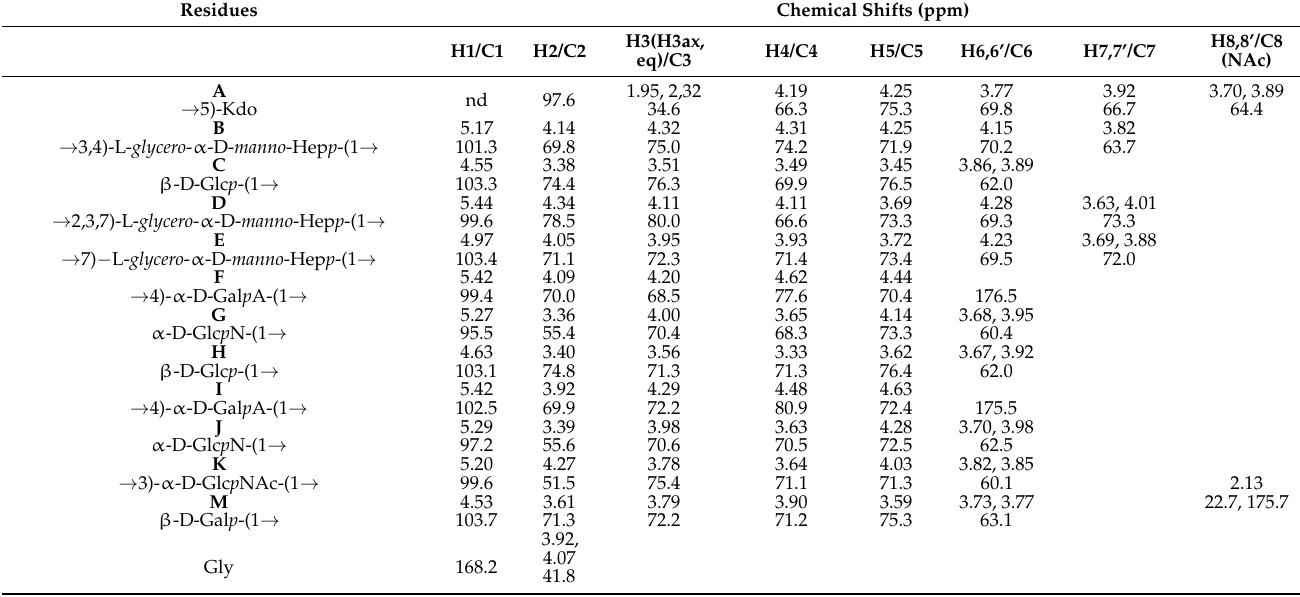
Table 1. Chemical shifts of the E. anguillarum 205/03 core oligosaccharide (OSVII).